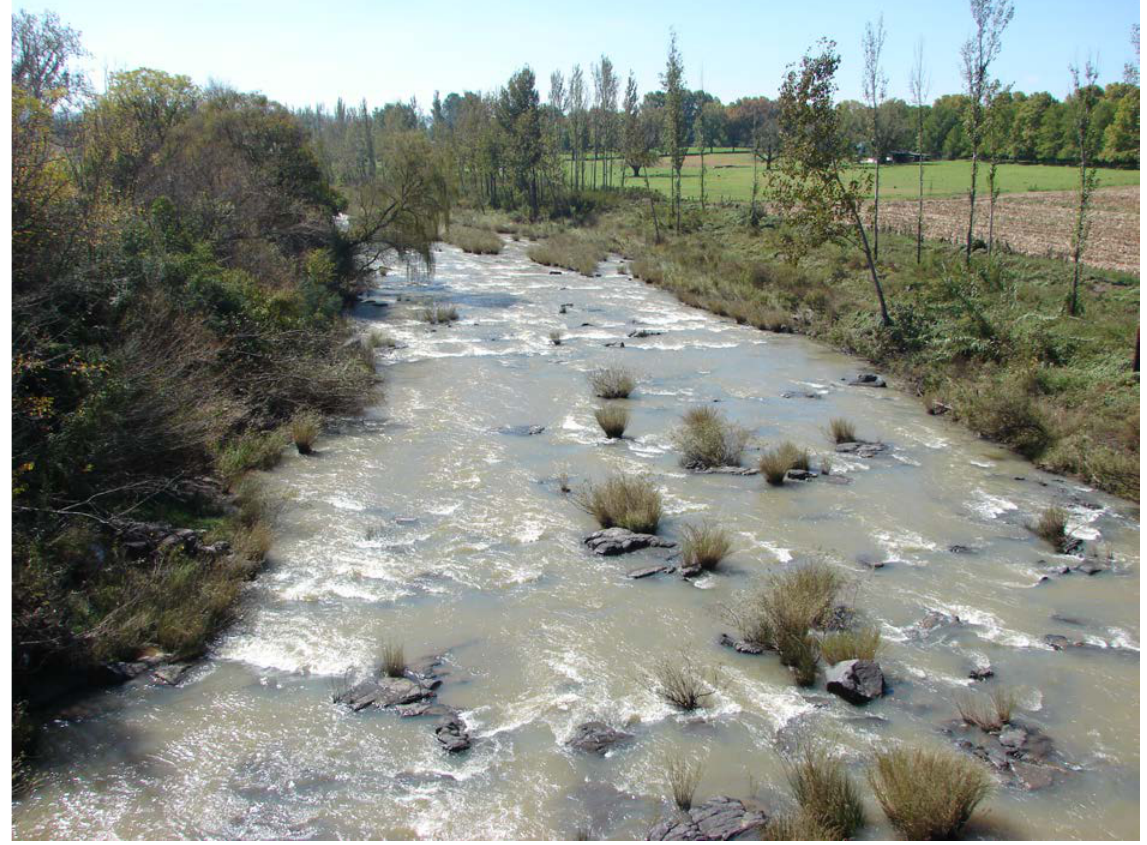
Illustration 12: The Tukhela River in KwaZulu-Natal was one of the first rivers on which hydrobiological studies were undertaken in South Africa under the Natal Rivers Research Fellowship.